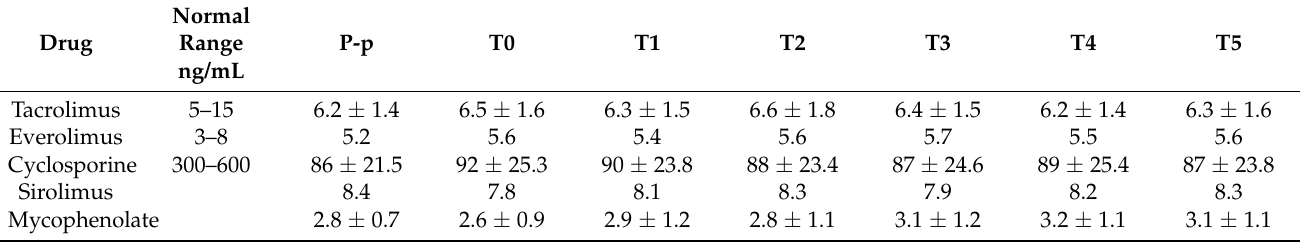
Table 2. The therapeutic drug monitoring of the immunosuppressants before and after I dose of vaccine and during the follow-ups. P-p: pre-pandemic. T0: admission; T1: II dose of vaccine: 3 weeks after T0; T2: 2 months after T1; T3: 3 months after T2; T4: 6 months after T1, in this time, the